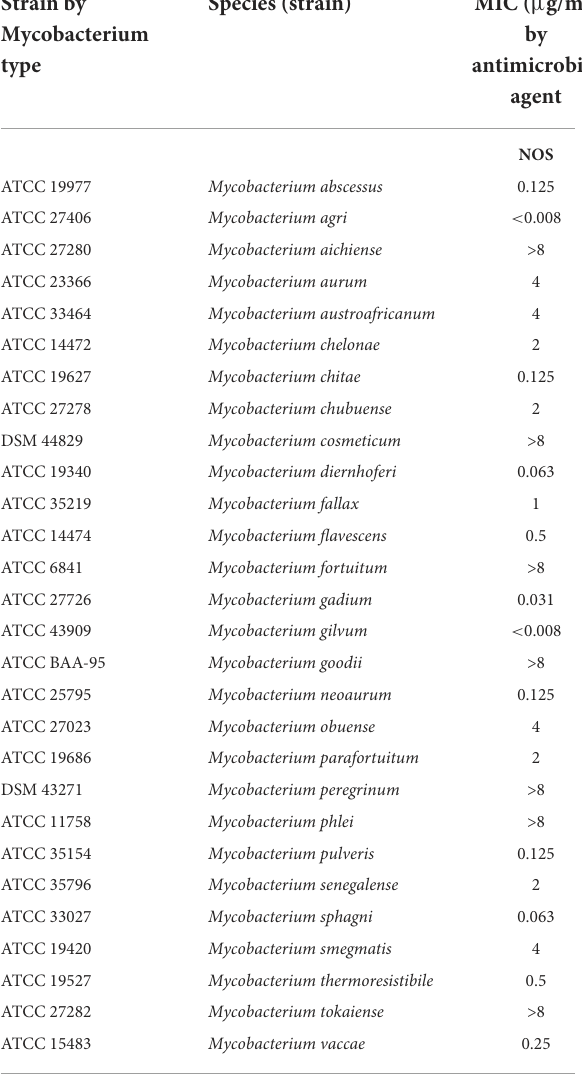
TABLE 1 Minimum inhibitory concentrations (MICs) of nosiheptide (NOS) against reference strains of 28 rapidly growing mycobacterium (RGM)